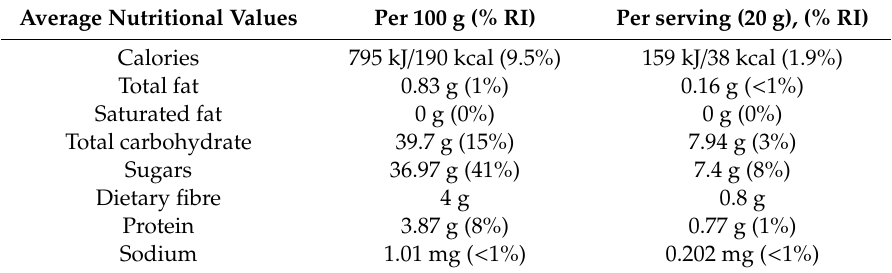
Table S2. Experimental Conditions.